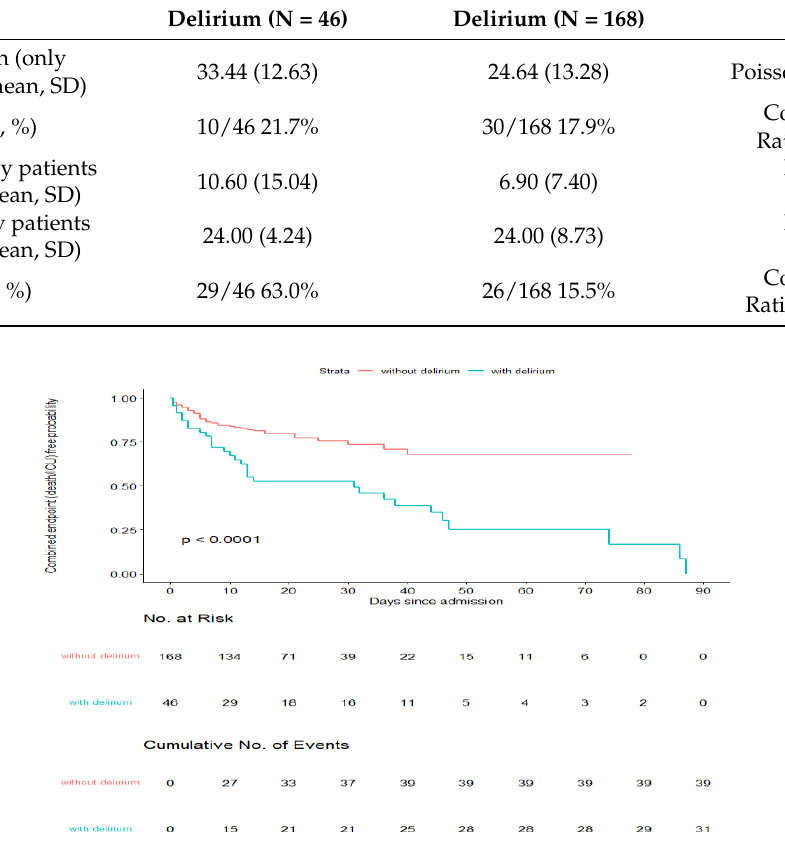
Figure 1. Kaplan – Meier survival curves according to presence/absence of delirium. Figure 1. Kaplan–Meier survival curves according to presence/absence of These predictors entered the stepwise multivariable model, which retained delirium as the strongest independent predictor (Table 7) of death/admission to ICU, together with only three other variables: Charlson Index without dementia, CRP and NLR. After divid- ing delirium by clinical type, the probability of death/admission to ICU was higher for patients with the hypoactive subtype than for those with the hyperactive subtype; patients with the mixed subtype had an intermediate risk (Table 7).